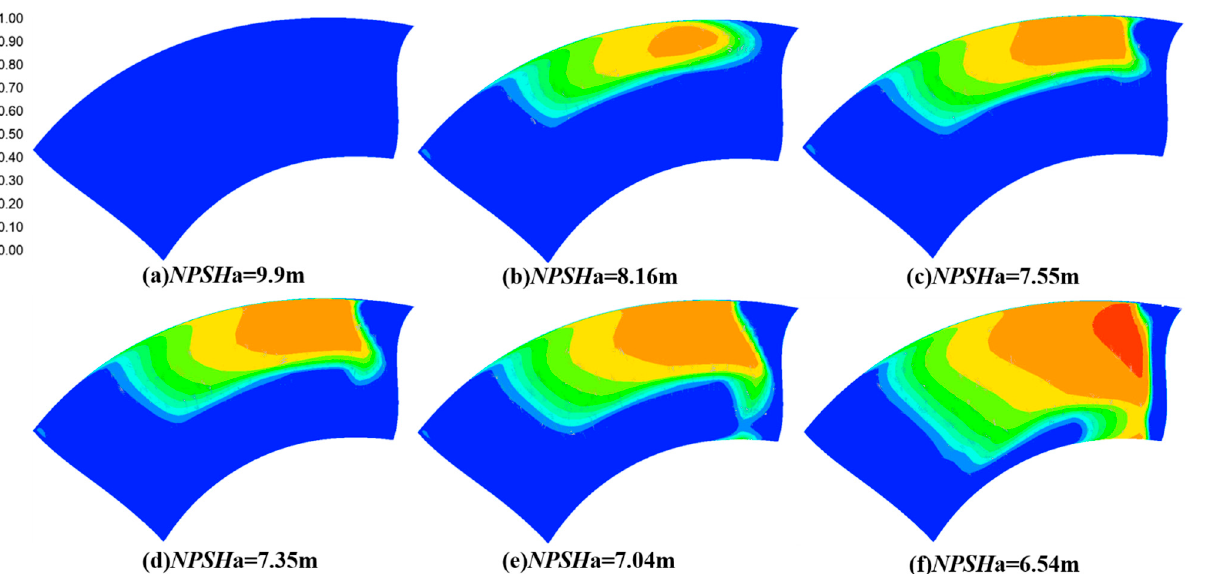
Figure 9. The VF of the impeller blade surface.